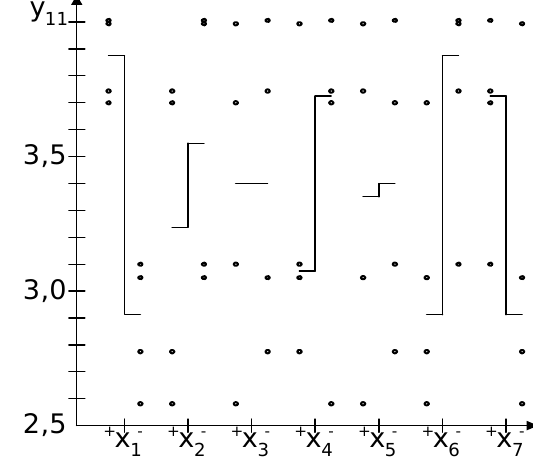
Fig. 3. Diagram of scattering of the influence of quantitative factors on the pH of the solution The diagram shows that the most significant fac- tors are x and x . Significant influence is shown by the 1 6 factors x and x . The lowest pH values were observed 7 4 with the addition of 0.0820 g of calcium